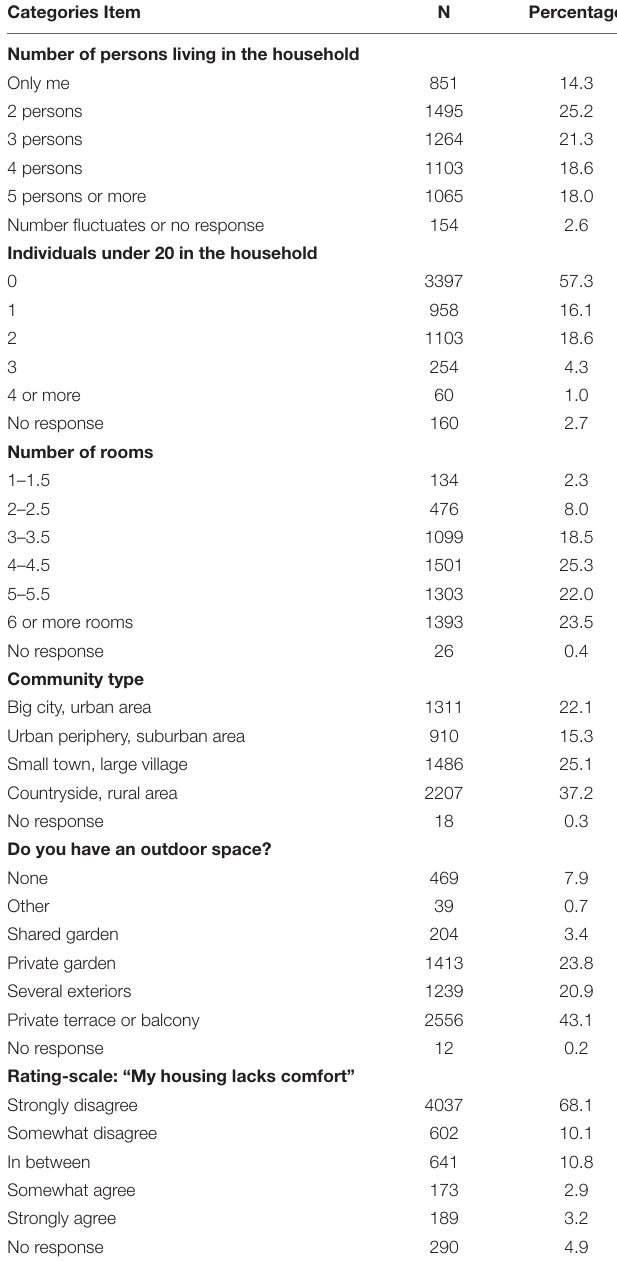
TABLE 2 | Distribution of the responses of the participants in items referring to the housing